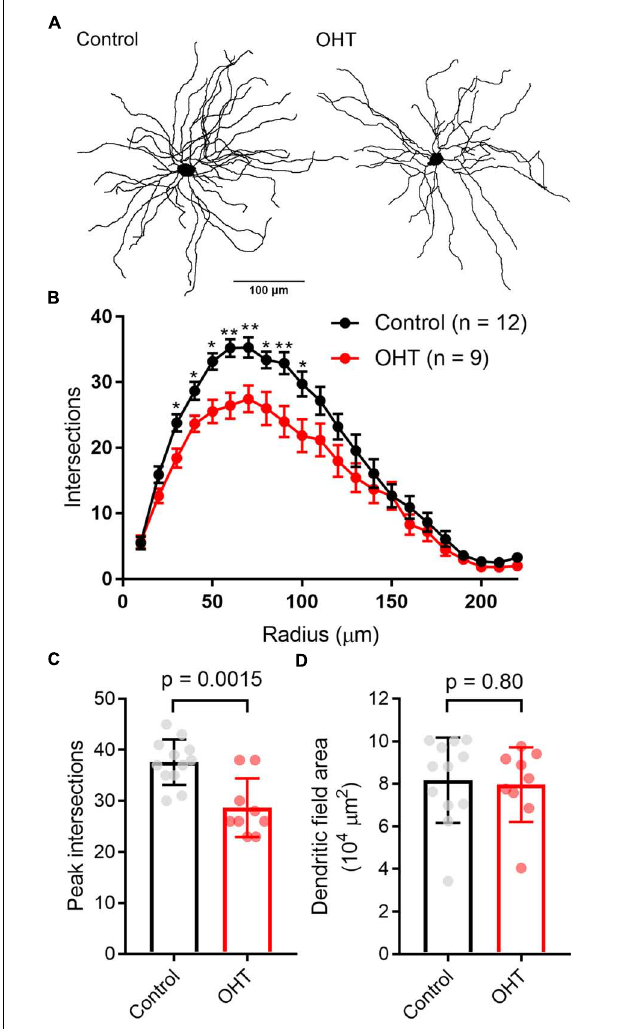
FIGURE 9 | Dendritic complexity of TC neurons in the dLGN is reduced by OHT. (A) dLGN TC neurons (Y-type profiles) were filled with neurobiotin during whole-cell recording for later 2-photon imaging and tracing of their dendritic profiles. (B) Sholl analysis of TC neuron dendritic complexity shows a reduction in the number of dendrite crossings in OHT TC neurons, consistent with some dendritic pruning or retraction. ∗ p < 0.05, ∗∗ p < 0.01. (C) The peak number of intersections was lower in TC neurons from OHT brain slices. (D) The dendritic field area, measured by drawing a convex polygon contacting distal dendritic tips, was not significantly different between OHT and control groups. In (C,D) , vGlut2 density and puncta size are plotted individually from each brain slice and the bar graphs show mean + standard